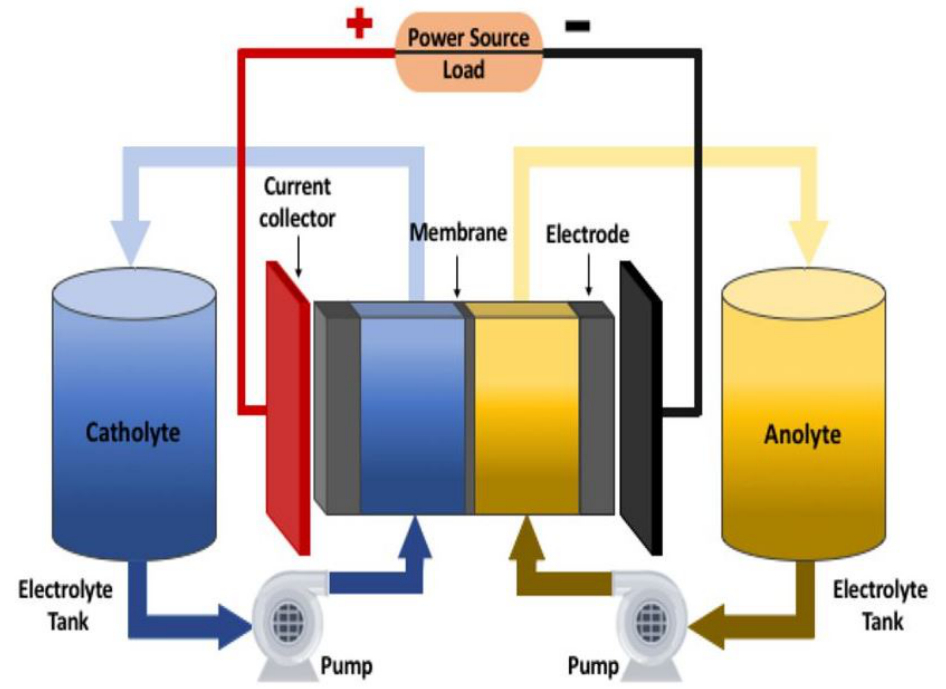
Figure 3. The design of a conventional flow battery system. Adapted from the paper written by Clemente et al. [31] under a Creative Commons Attribution License 4.0 (CC-BY